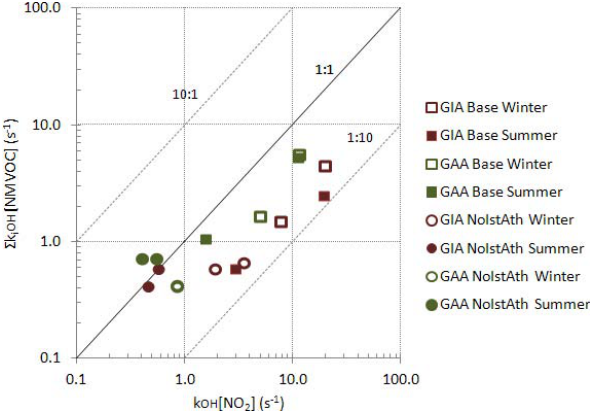
Fig. 4. Integrated NMVOC reactivity with regard to OH radical as a function of NO 2 reactivity with regard to OH radical at GIA (pur- ple) and GAA (green) for summer (July 2008; closed symboles) and winter (December 2008; open symboles) for the “Base” (squares) and the “NoIstAth” (circles) simulations. Values averaged for rural and for urban cases separately. The 10:1, 1:1 and 1:10 lines are plotted for clarity. Units are s − 1